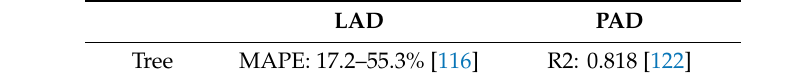
Table 10. Examples of MAPE and R2 for plant canopy 3D structure parameters measurement.